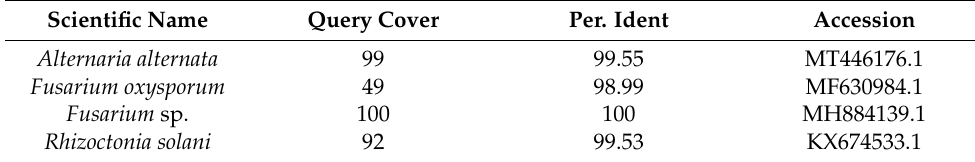
Table 2. BLAST homolog search results in NCBI.